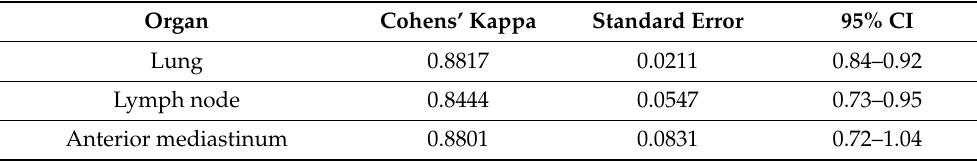
Table 5. Cohen’s kappa for “C1–C5 classification” divided for